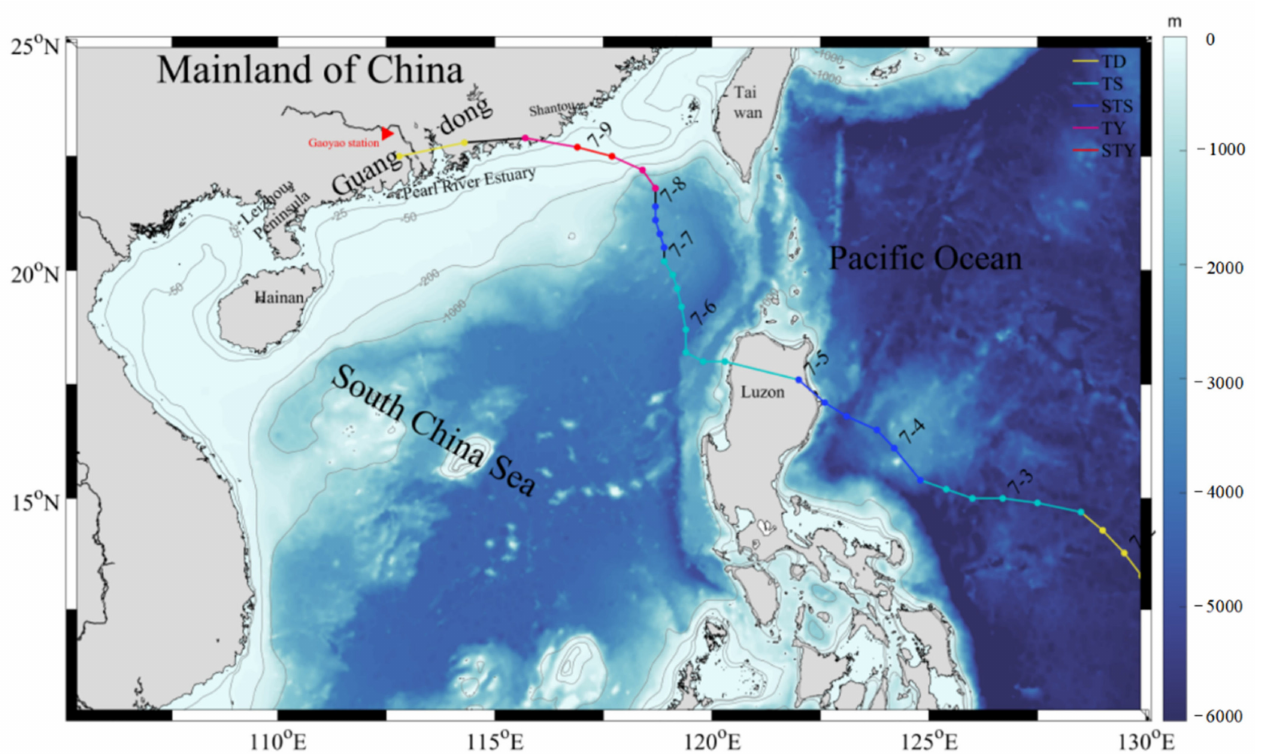
Figure 1. Typhoon path in the northern SCS. The colored dots indicate the center of typhoon with 6-h interval. The red triangle denotes Gaoyao station.